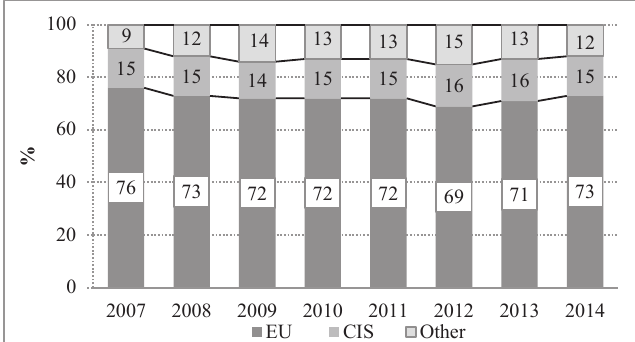
Fig. 2. Export structure of Latvian goods, for groups of countries, in % (CSB of Latvia).